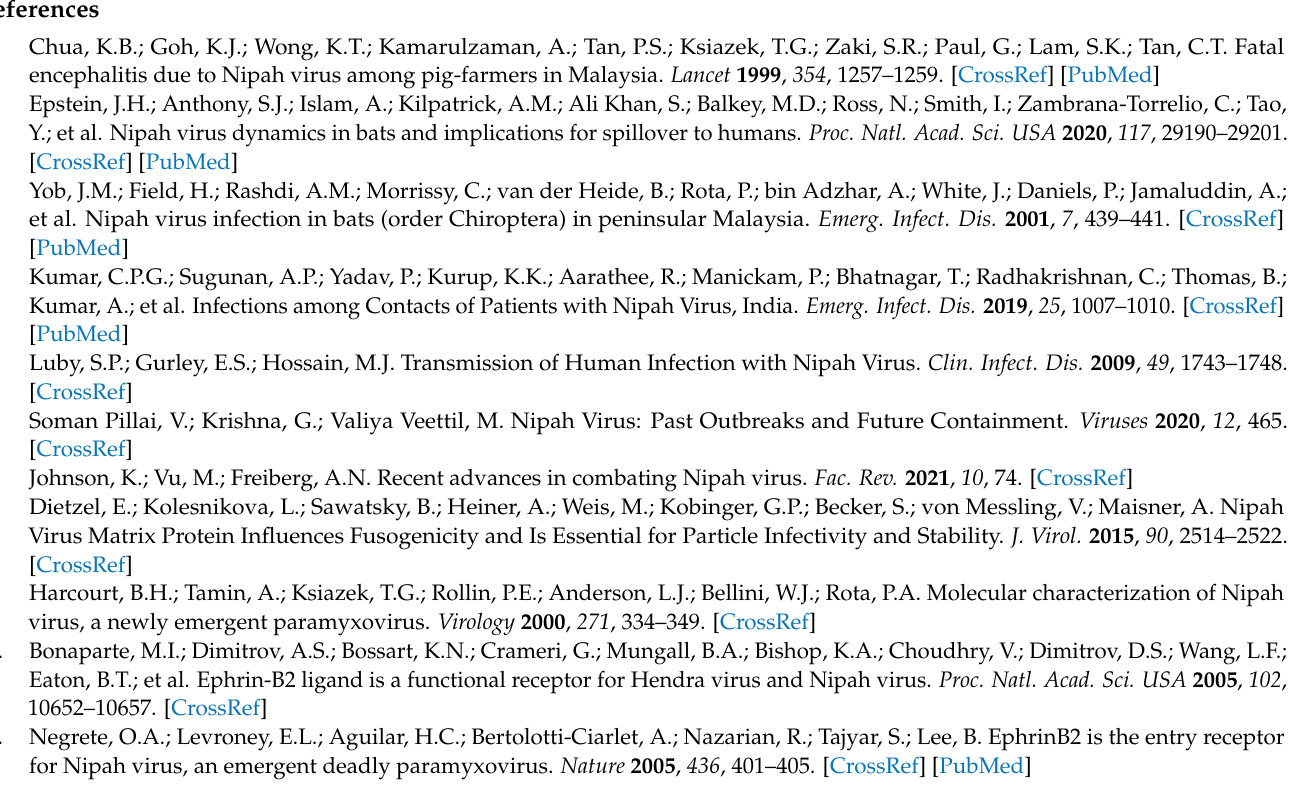
Table S2: Primer pairs used for qPCR; Figure S1: Wildtype NiV P but not STAT1-binding defective NiV P G125E blocks nuclear STAT1 accumulation in IFN-treated